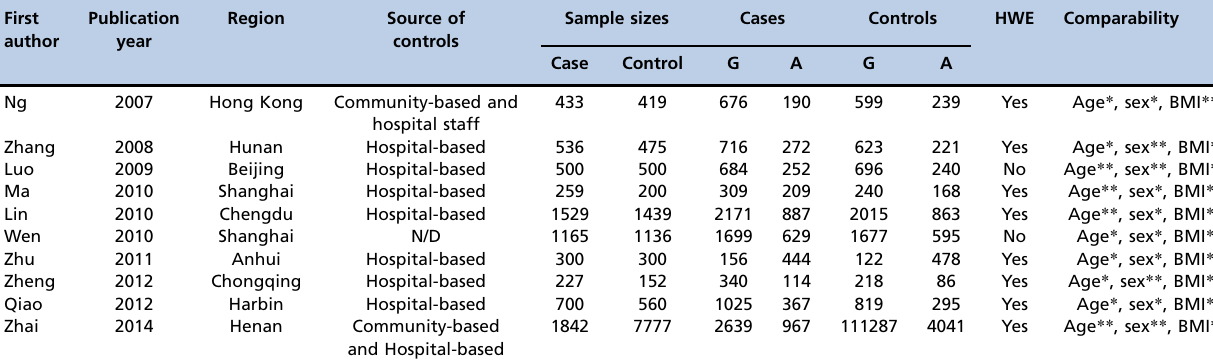
Table 1 - The basic characteristics of the included studies addressing rs11196218.